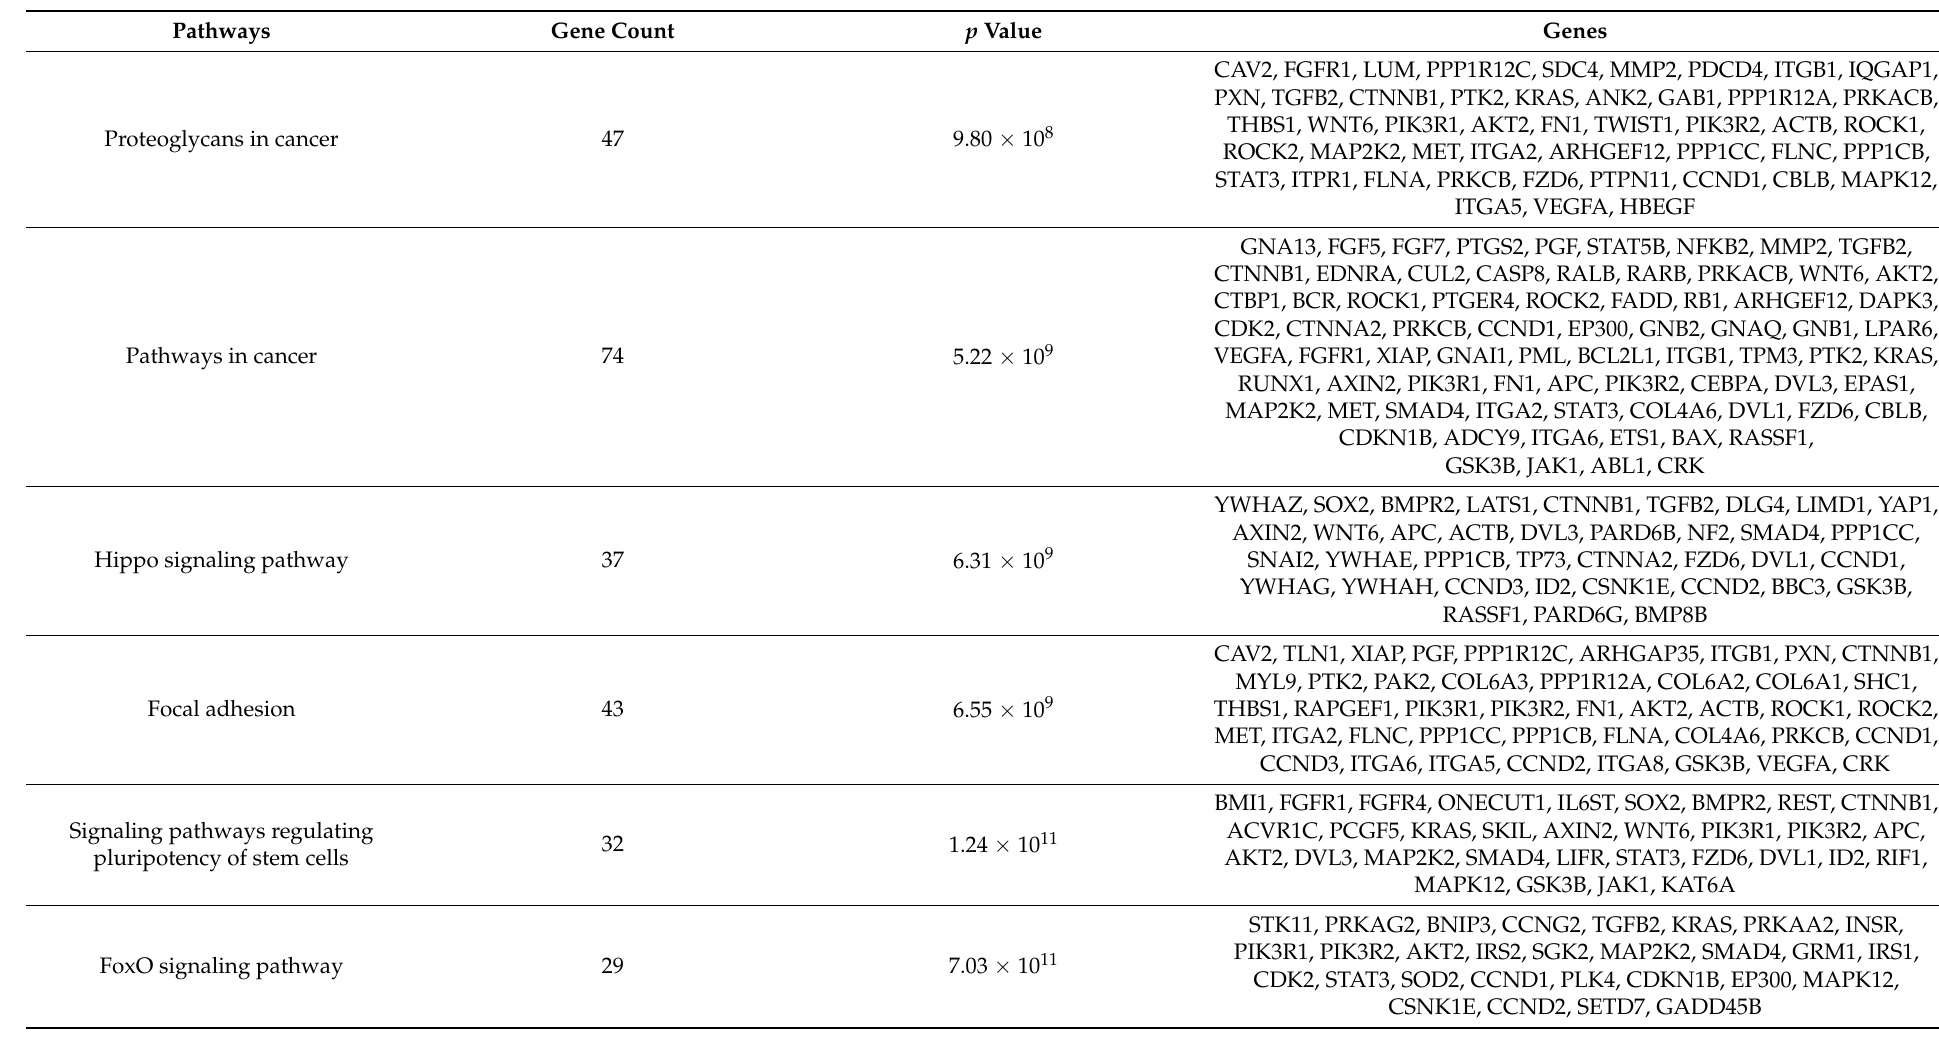
Table 2. Top 15 statistically relevant pathways activated in U87 glioblastoma cells exposed to 2Gy PT irradiation under hypoxia